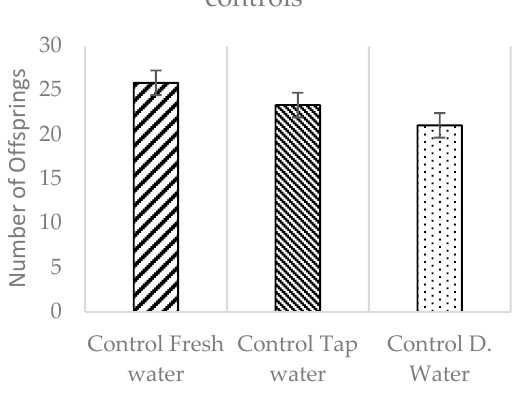
Figure 3. Reproduction behavior of E. albidus comparing three different types of water.